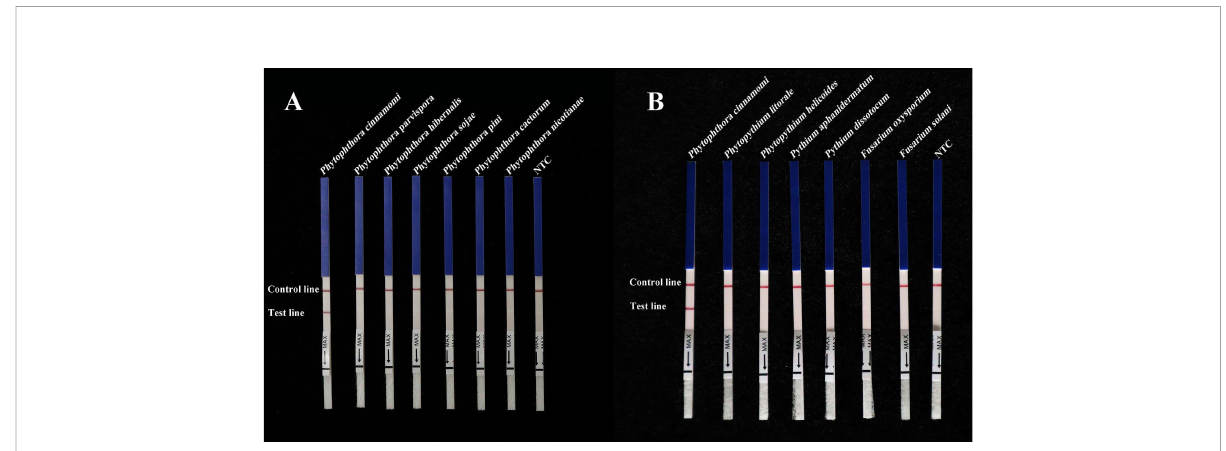
FIGURE 3 RPA-LFD assays were used to speci fi cally detect P. cinnamomi . (A) All dipsticks yielded visible control lines, indicating validation tests. No test lines were detected in those featuring gDNA (100 ng) from other Phytophthora species or in NTCs. (B) Using the RPA-LFD assay, all dipsticks yielded visible control lines, indicating valid tests. No test line was detected for the gDNA (100 ng) of Phytopythium species, Pythium species, fungal species, Bursaphelenchus species, or in the NTCs. NTC, negative control. Experiments were repeated three times; all replicates showed the same